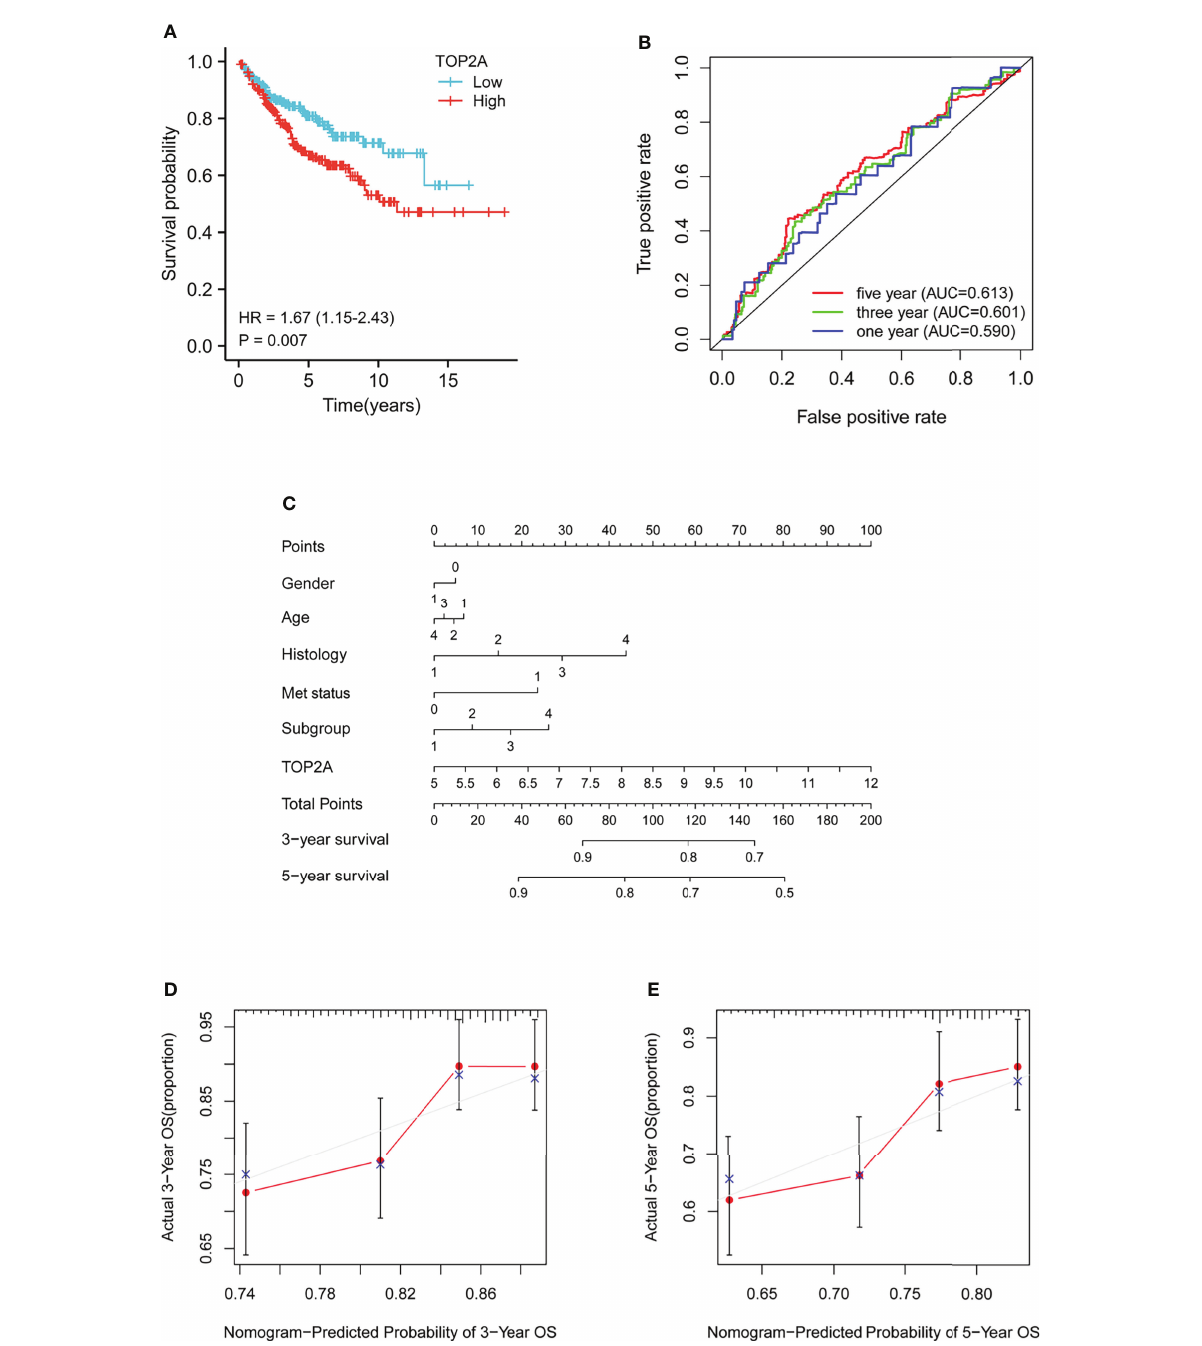
FIGURE 3 Prognostic analysis of TOP2A in MB patients in GSE85217 dataset. (A) Kaplan-Meier survival curves of the high and low TOP2A expression groups divided by the median score. (B) ROC curve analysis of the prognostic value of TOP2A for MB patients. (C) Nomogram for predicting 3- and 5-year survival rates of MB patients. The variables include gender (0, female; 1, male), age (1, 0-3 years; 2, 3-10 years; 3, 10-17 years; 4, 18+ years), histology (1, classic; 2, desmoplastic; 3, LCA; 4, MBEN), met status (0, M0; 1, M1), molecular subgroup (1, WNT; 2, SHH; 3, Group3; 4, Group4) and TOP2A expression, which were integrated in the nomogram. (D, E) The calibration curves for predicting survival probability at 3 and 5